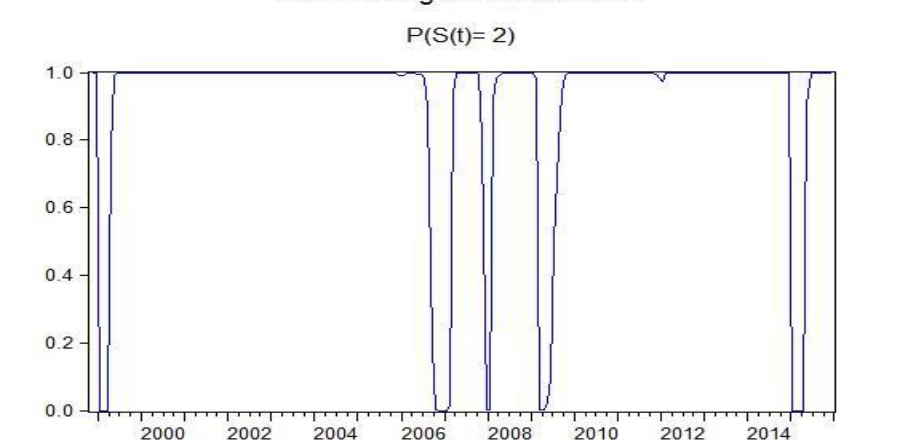
Figure 1 : Smoothed Probability of Financial Episodes (1998-2015) for the Bangladeshi Banking